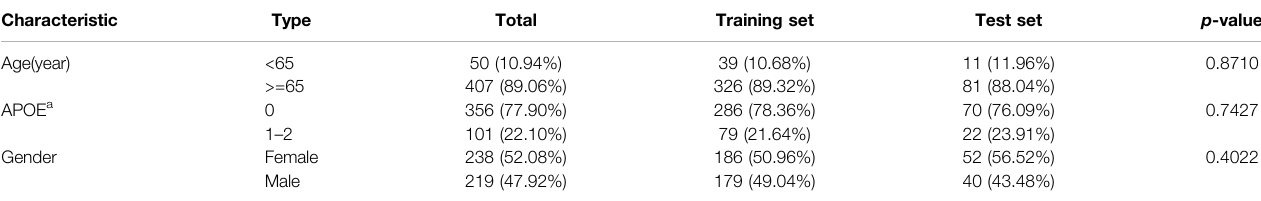
TABLE 1 | The age, gender, and APOE ε 4 genotype information in the training and test sets.